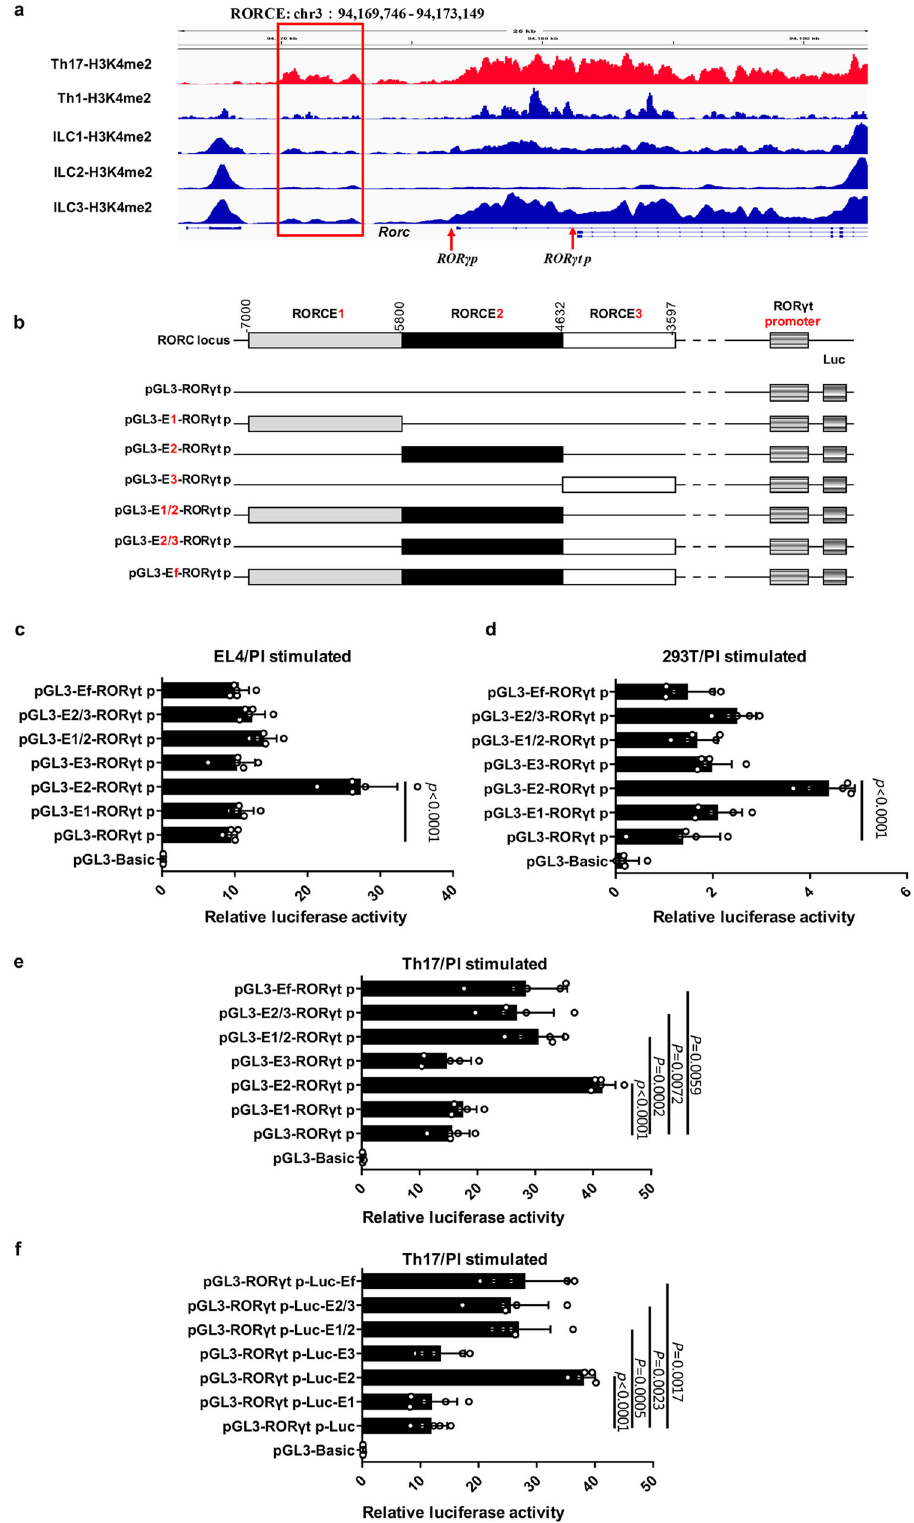
(Fig. 2c and d). Because ROR γ t is required for the induction of IL-17A transcription in Th17 cells 11 , we found that RORCE2 de fi ciency resulted in signi fi cant decreases in the expression of IL- 17A and frequency of CD4 + IL-17A + Th17 cells in the splenic CD4 + T cells (Fig. 2e – g and Supplementary Fig. 3b). Similar results were observed in the lamina propria (LP) in mouse